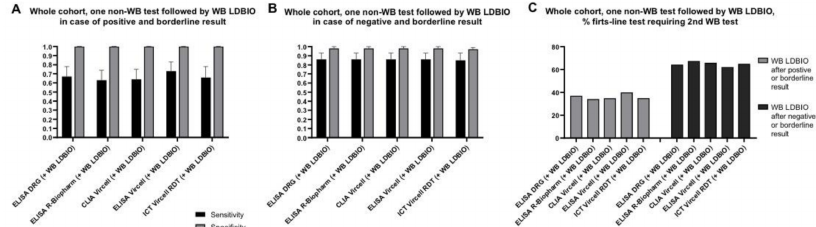
Figure 4. Diagnostic performance of the combination of each non-WB assay followed by LDBIO WB, on the whole sera cohort. Sensitivity and specificity of assays when borderline results were considered as positive ( A ) and negative ( B ). Percentage of first-level non-WB tests requiring a second WB test ( C ). Error bars represent 95% CI. Of note, CLIA Vircell and ELISA Vircell contain the same antigenic preparation, therefore its combined use should be avoided; data relative to this combination are presented for completeness.